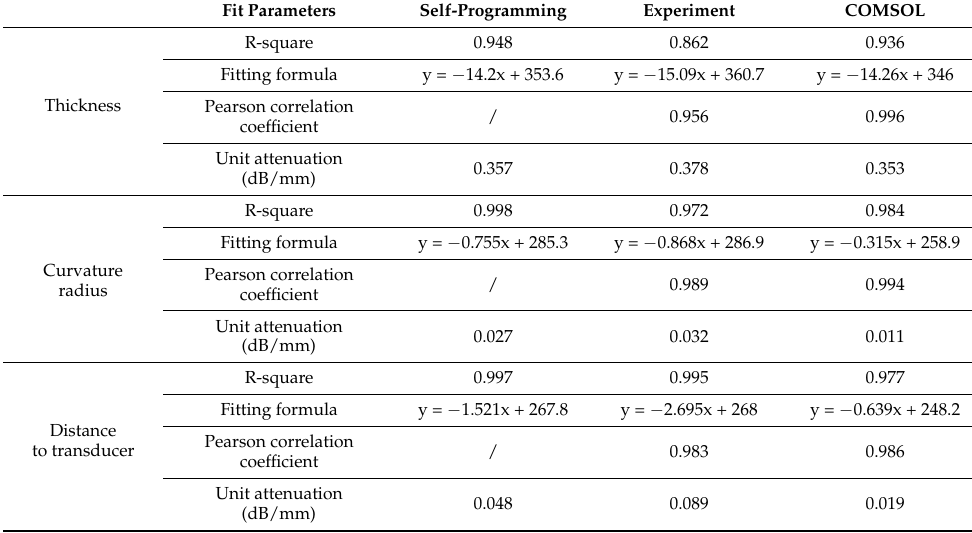
Table 3. Structural parameters fitting results.